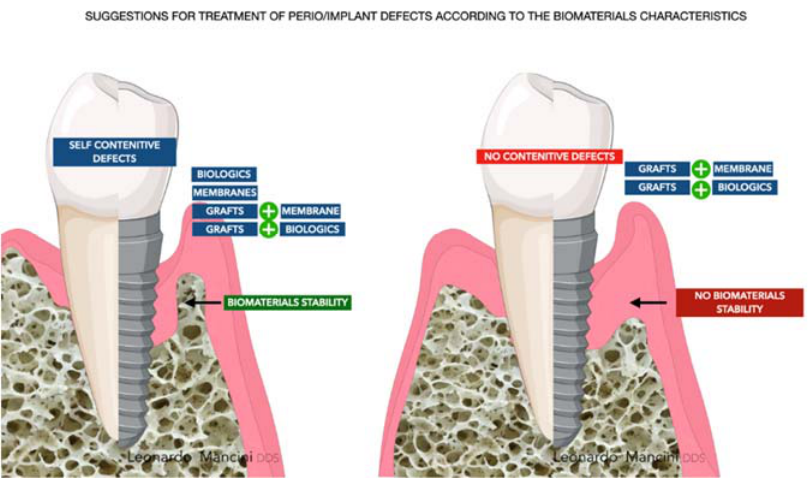
Figure 9. Biomaterials and their possible implications in periodontal/peri ‐ implant regeneration.